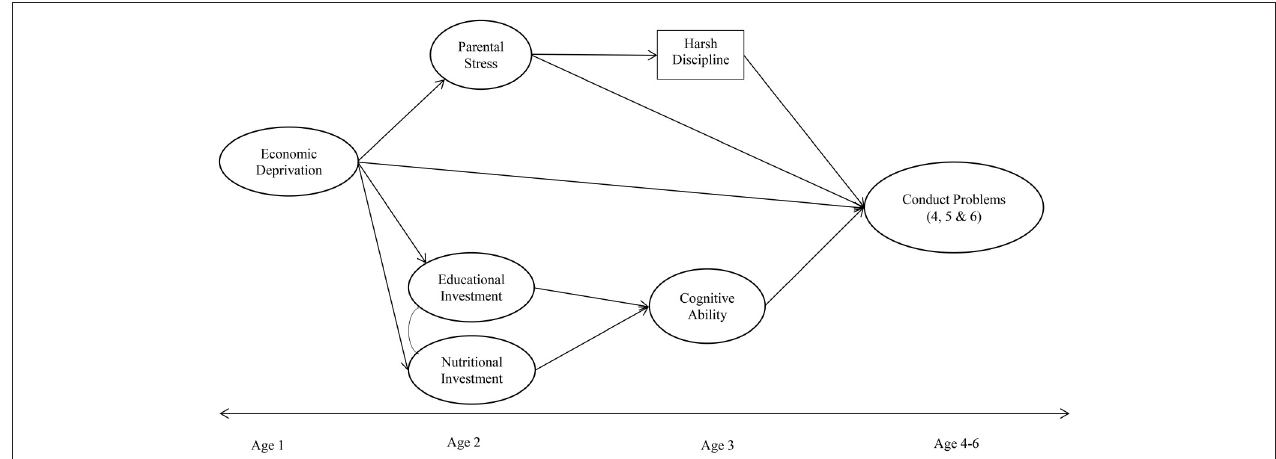
FIGURE 1 | An integrated family stress and investment model for childhood conduct problems. Only latent factors are shown here for purposes of simplicity. All latent constructs (except Harsh Discipline) were measured with multiple indicators. Please see section on methodology and Table 1 for number of items used to measure each construct and model